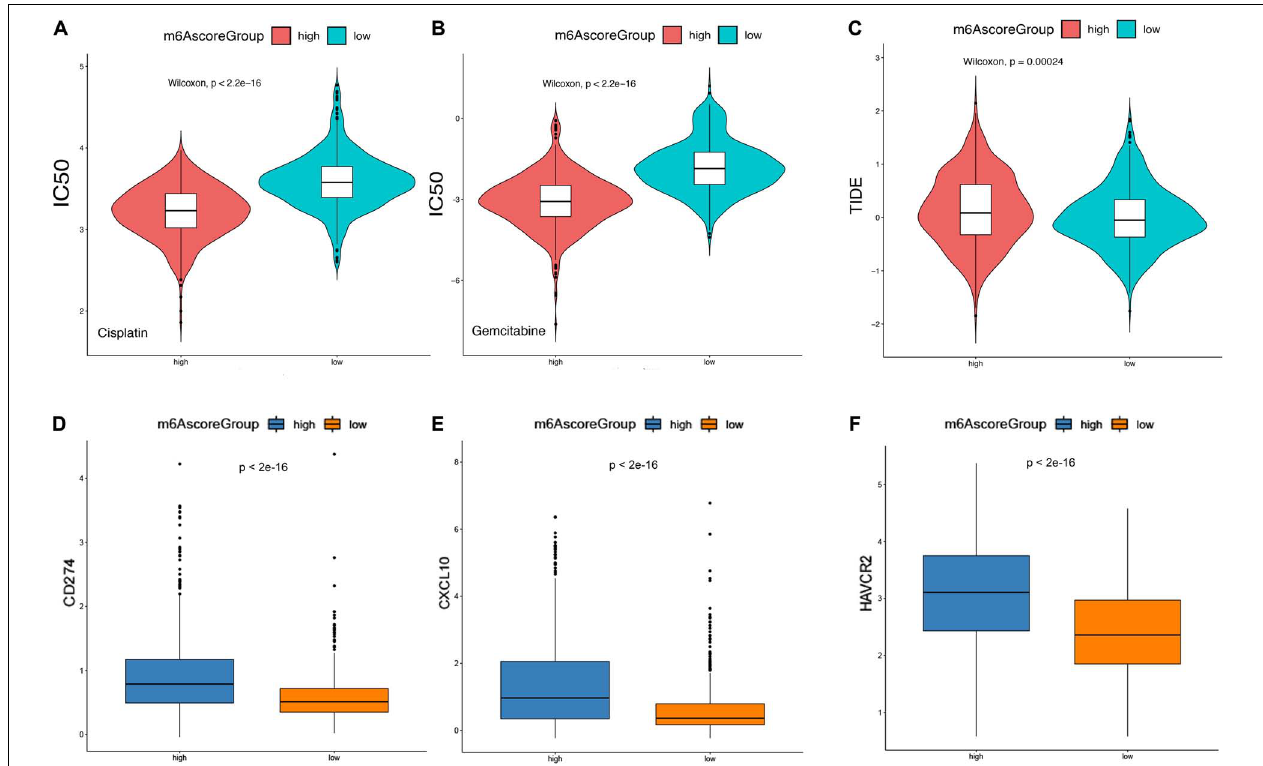
FIGURE 9 | m6Ascore provided predictive outcomes for LGG patients receiving immunotherapies. (A,B) The difference between the IC50 values of Cisplatin and Gemcitabine in the samples of the high-risk group and the low-risk group. (C) The difference of TIDE score between samples of high-risk group and low-risk group. (D–F) Analysis of the degree of correlation between the TIDE score in multiple cohorts and the differential expression of immune checkpoint molecules. (D) CD274, (E) CXCL10, (F) HAVCR2.